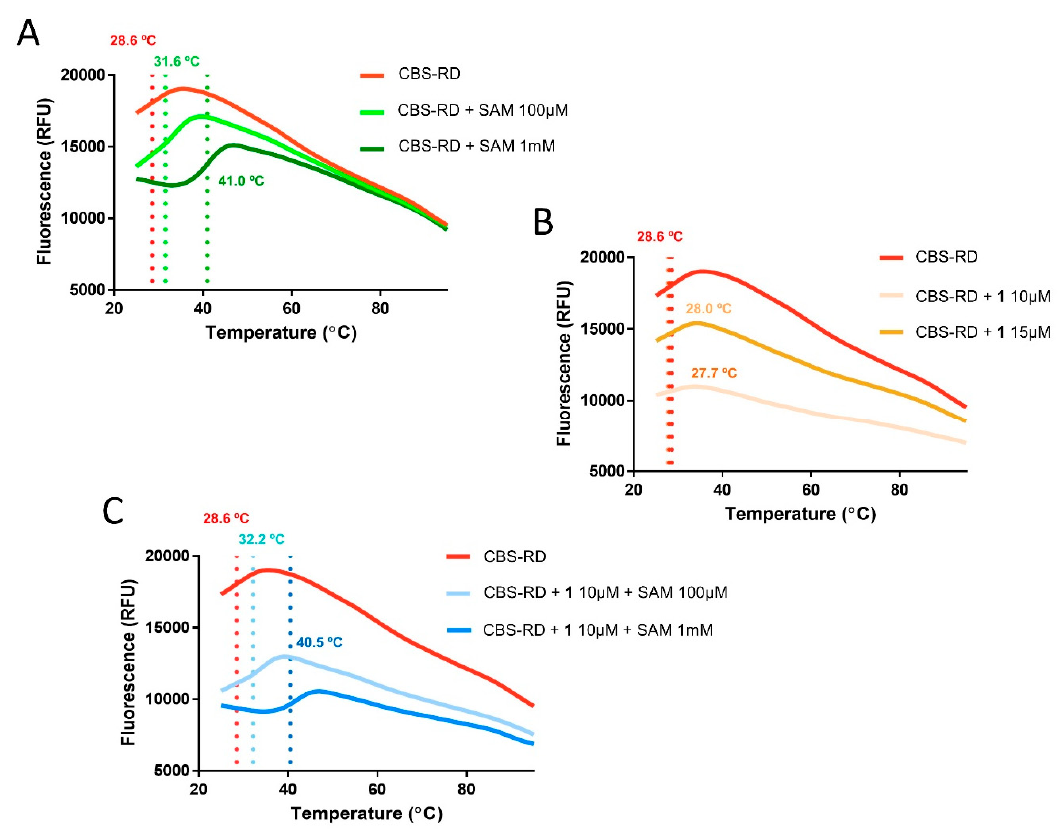
Figure 3. Di ff erential scanning fluorimetry was implemented to identify a possible binding interaction of the inhibitor 1 with the regulatory domain of CBS (CBS-RD). A series of representative melting curves as those shown above, suggest that 1 does not bind CBS-RD. ( A ) Addition of the cofactor S -adenosylmethionine (SAM) (100 μ M, light green, T m : 31.6 °C; 1 mM, dark green, T m : 41.0 °C) results in a dose-response stabilization effect on CBS-RD as compared to the apoprotein (red, T m : 28.6 ◦ C). ( B ) In contrast, no stabilization is monitored by increasing concentrations of 1 (10 μ M, light brown, T m : 28.0 ° C; 15 μ M, dark brown, T m : 27.7 °C). ( C ) Co-administration of SAM and 1 (100 μ M SAM, 10 µ M 1 , light blue, T m : 32.2 ° C; 1 mM SAM, 10 μ M 1 , dark blue, T m : 40.5 °C) results in a stabilization and response that are practically identical to the case where only SAM is bound to CBS-RD, showing